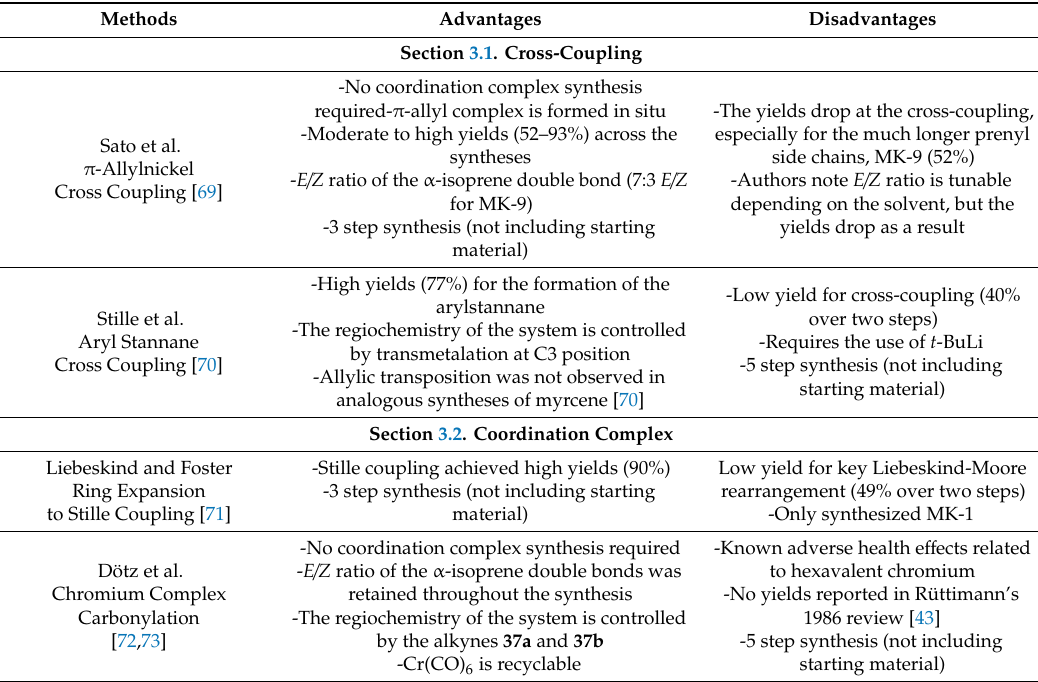
Table 6. Summary of metal-mediated